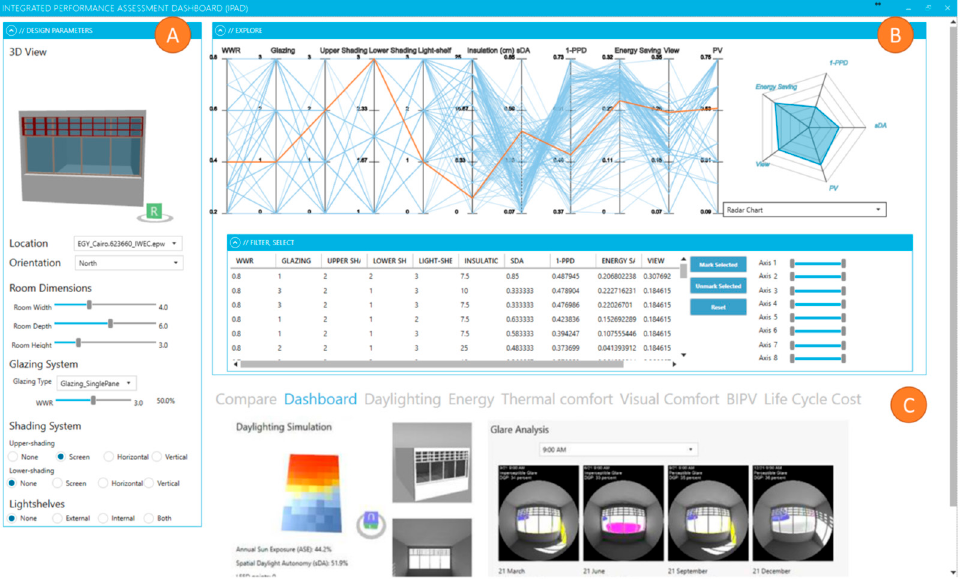
Figure 10. Visualization interface: ( A ) context and design parameters panel, ( B ) explorer panel, and ( C ) integrated dashboard. © (2017) eCAADe 35 conference proceedings, from Gadelhak et al. [10].